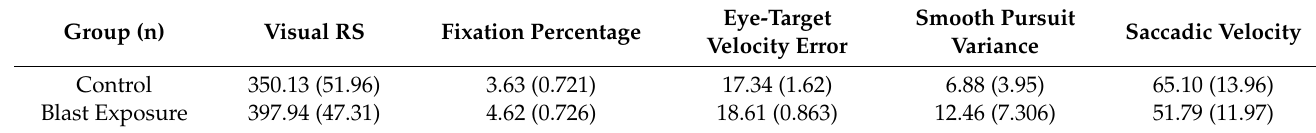
Table 3. Mean and standard deviation for fixation stability variables.